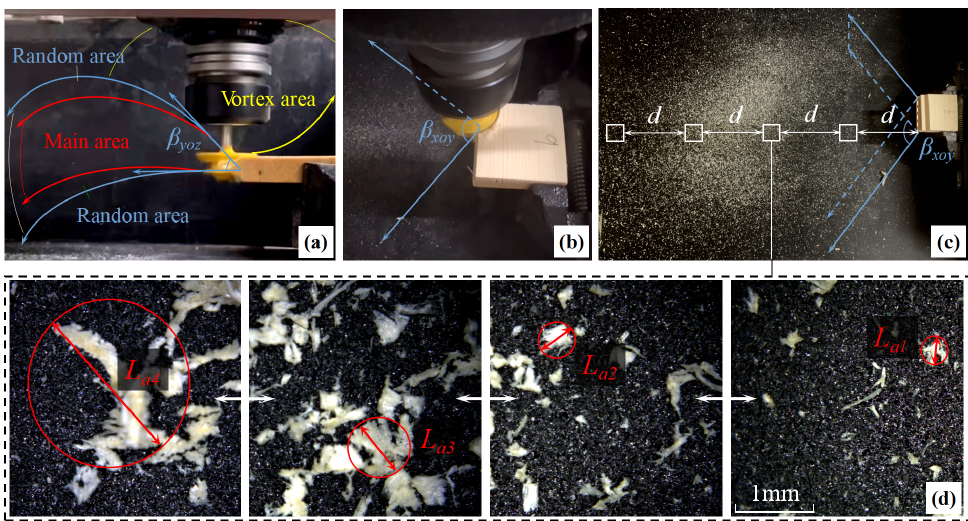
Figure 5. Milling test results and observed chip sizes. ( a ) Front view of test No. 6. ( b ) Top view of test No. 9. ( c ) Test No. 6 top view of the scattered state of chip distribution after machining. Four equally spaced areas of d were taken and then photographed using a portable microscope. ( d ) The four white square areas in Figure ( c ) were photographed by a 1000× portable microscope. L a1 to L a4 are the average chip sizes in these four areas, respectively.